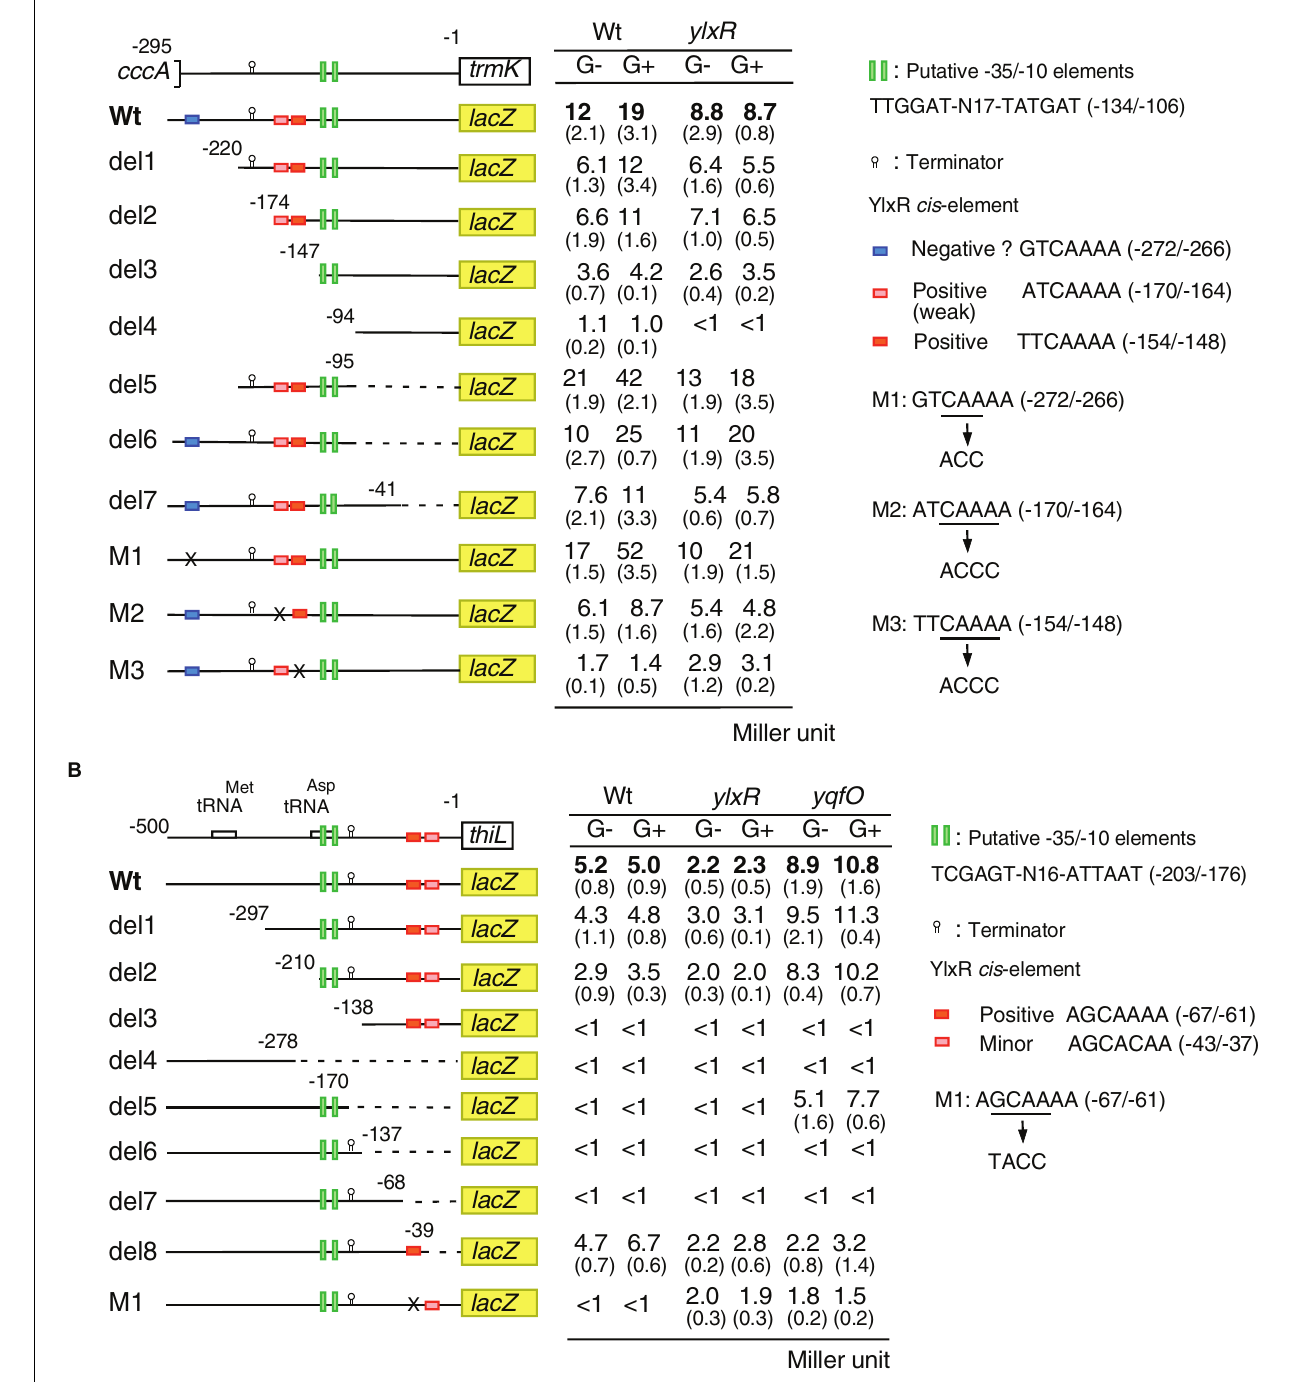
Frontiers in Microbiology |